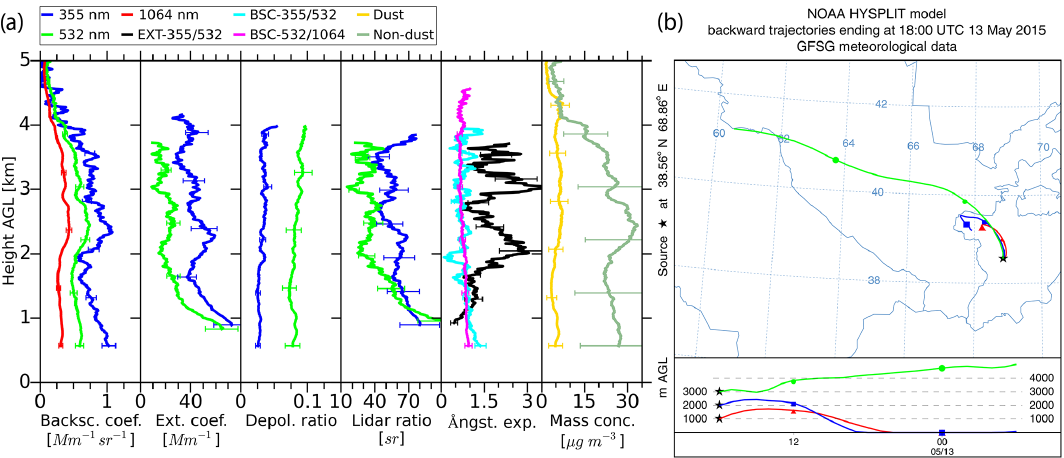
Figure 8. Case 4: a contrasting case with local pollution is shown. (a) Same as Fig. 5b. Averaged lidar profiles measured on 13 May 2015, 18:10–20:30 UTC. Lidar signals are smoothed before calculation of the extinction-related (788m) and backscatter-related (98m) optical properties. (b) 48h HYSPLIT backward trajectories arriving at Dushanbe at 18:00UTC at 1, 2, and 3km